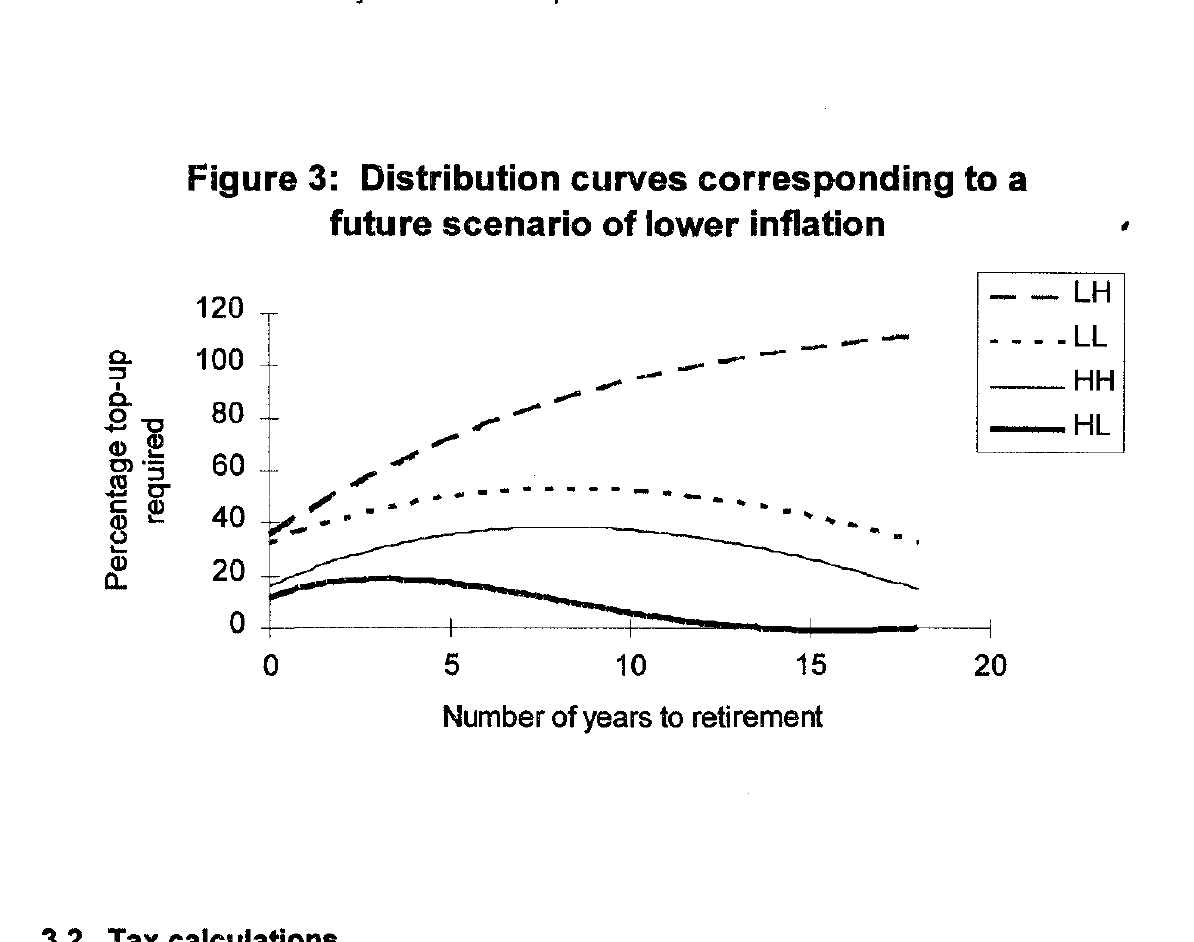
Figure 3: Distribution curves corresponding to a future scenario of lower